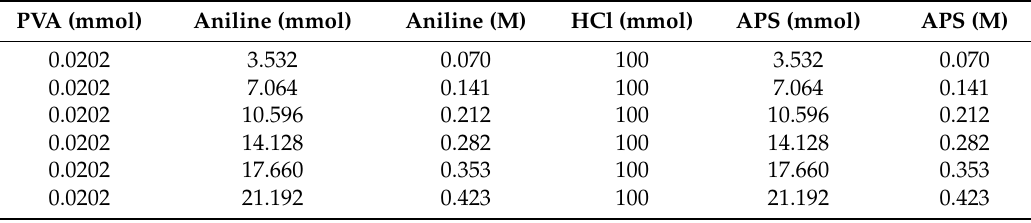
Table 2. Monomer and intermediary molar